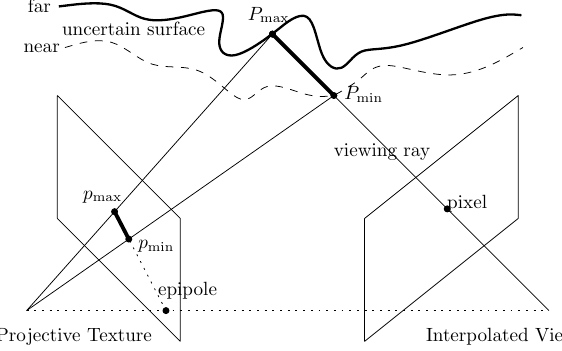
Figure 1: Epipolar filtering geometry